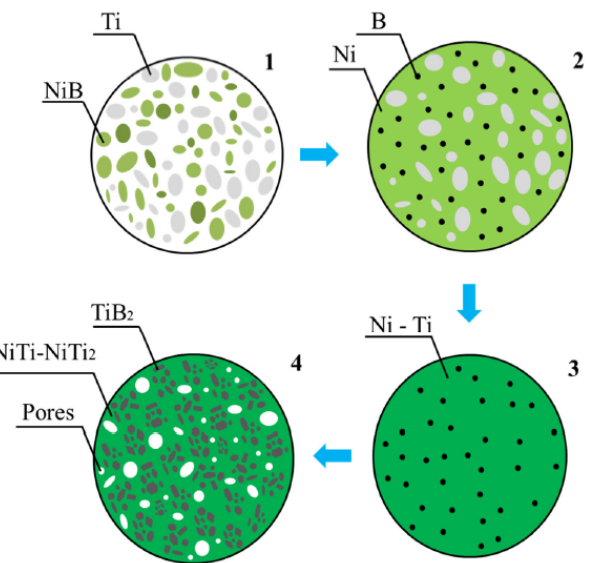
Figure 8. Schematic of the formation of the structure of the (Ni-Ti)-TiB2 SHS composite in the course of the combustion of the Ti-NiB powder